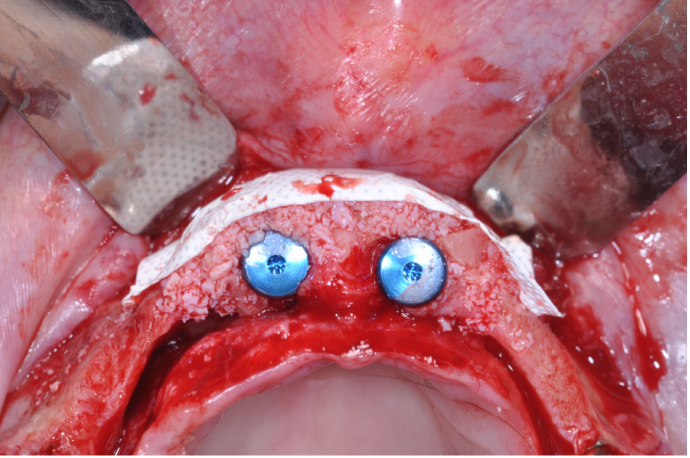
Figure 11. Particulate bone graft and non-resorbable membrane in position and far away from the incision